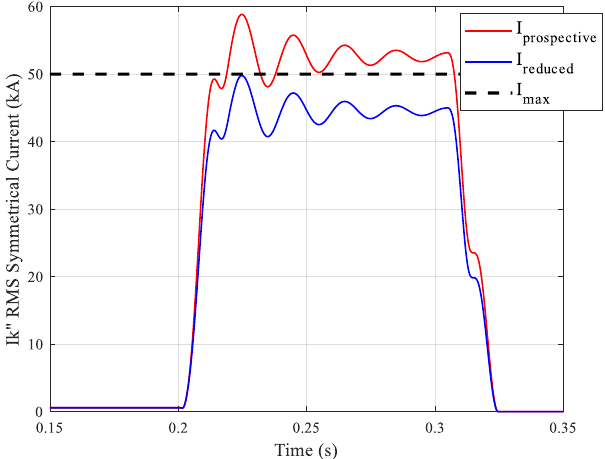
Figure 11. Ik ” RMS symmetrical current by CB-L1, phase a. Figure 11. Ik” RMS symmetrical current by CB-L1, phase